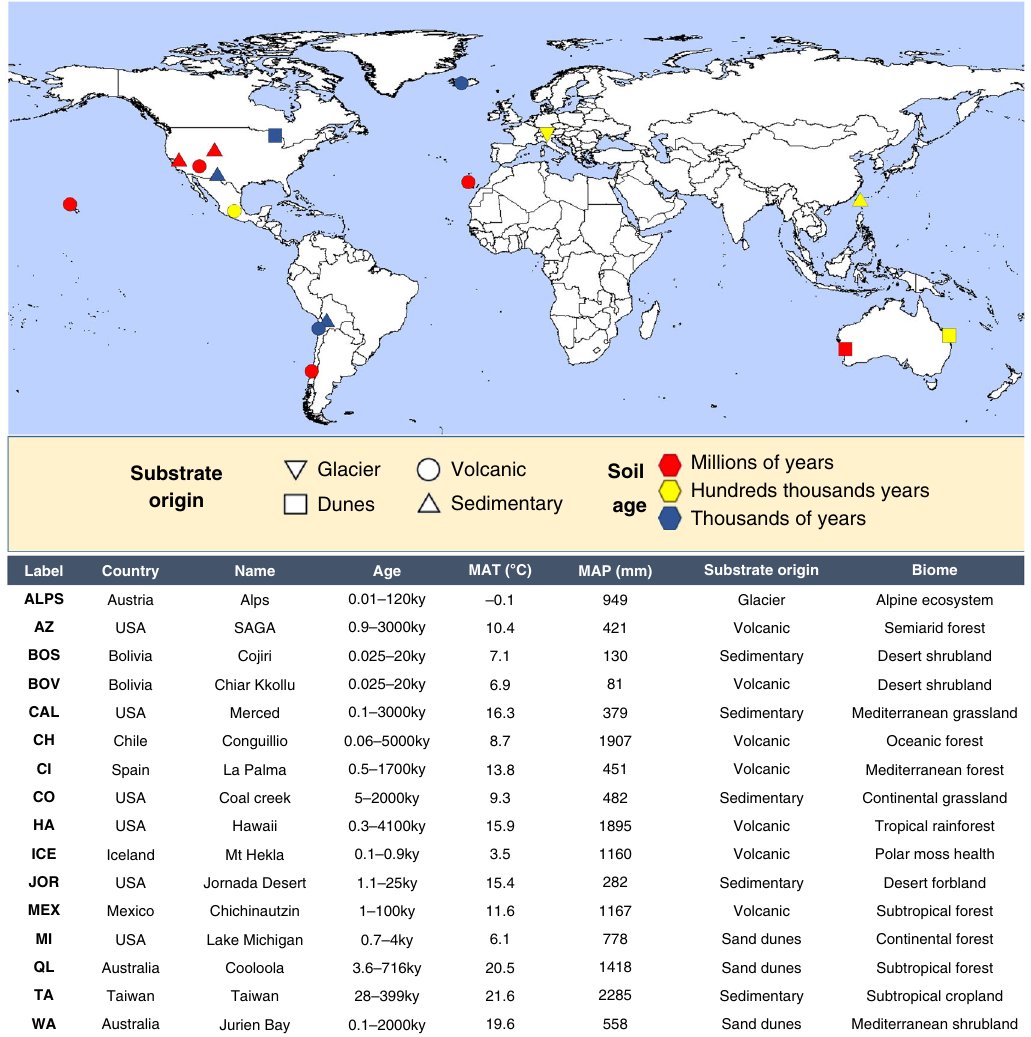
Fig. 1 Information on the investigated 16 soil chronosequences. Location, soil age, climate, vegetation, and chronosequence origin for the 16 globally distributed chronosequences included in this study. Blue, yellow, and red locations include chronosequences for soil ages ranging from centuries to thousands, to hundreds of thousands, and to millions of years, respectively. See Supplementary Table 1 for further details on these